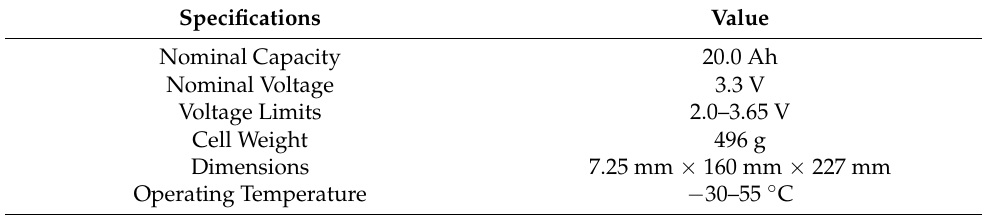
Table 1. Lithium-ion pouch cell specifications.